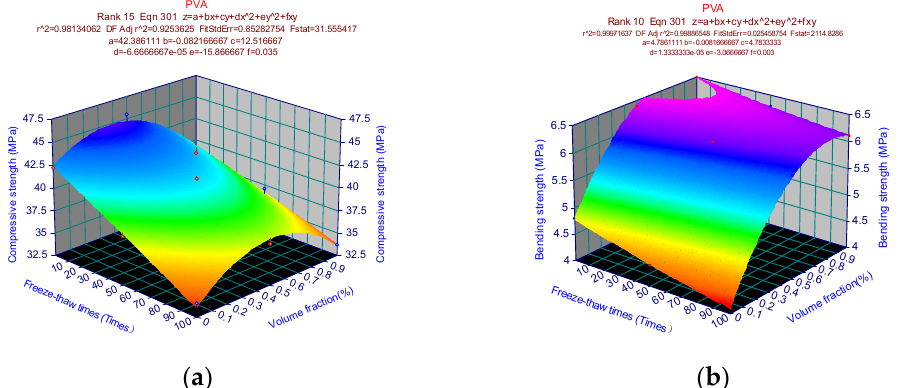
Figure 18. PVA fiber strength prediction mode: ( a ) Compressive strength prediction model; ( b ) Bend-